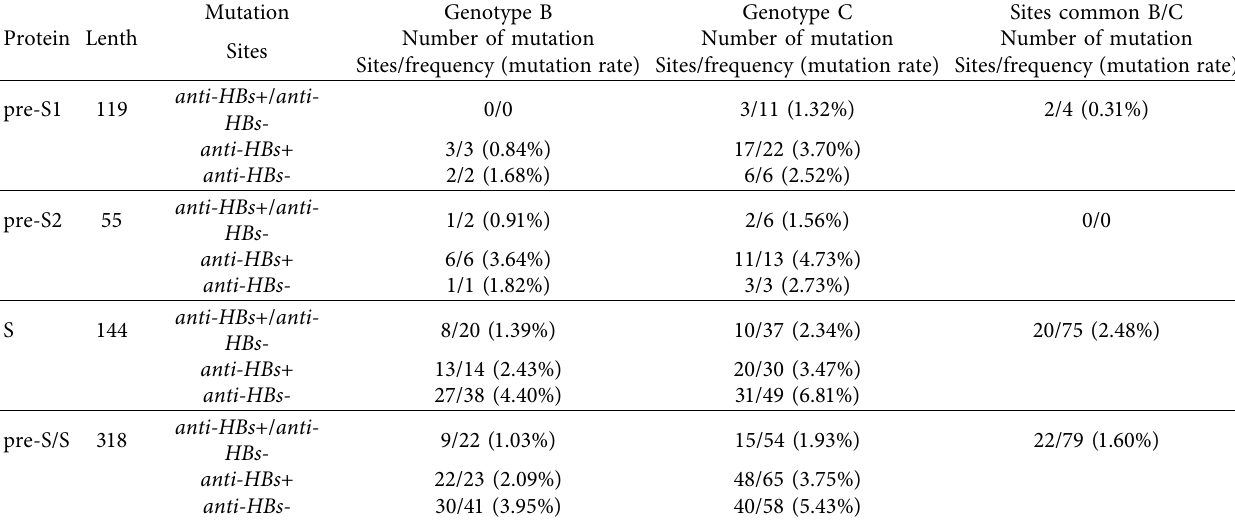
B and OBI C strains with anti-HBs positive or negative.